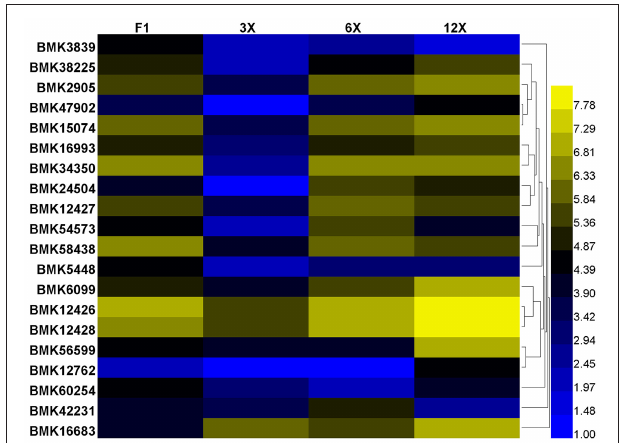
FIGURE 6 | Differential expression of the expansin family genes in Dendrocalamus latiflorus plants with different ploidy levels based on the DGE data. Color scale represents log2 expression values.